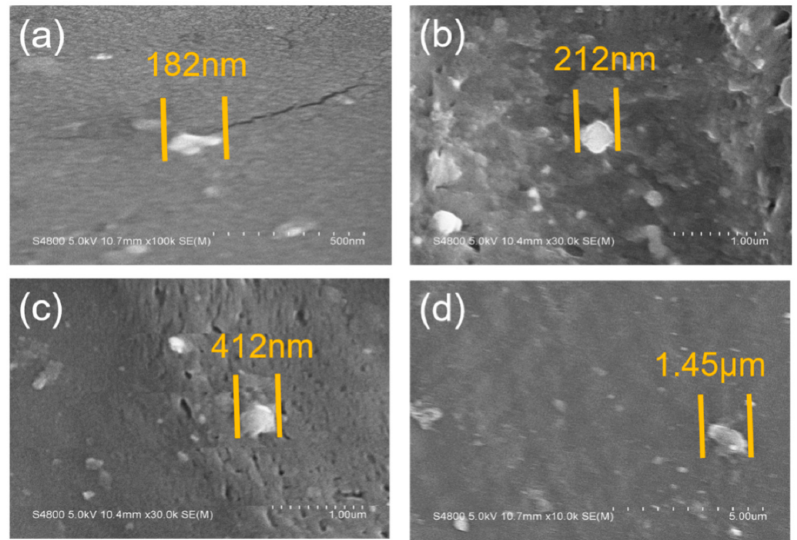
Figure 5. The size of H-PAAS islands scattered in the PP sea; ( a – d ) represented four kinds of H-PAAS island